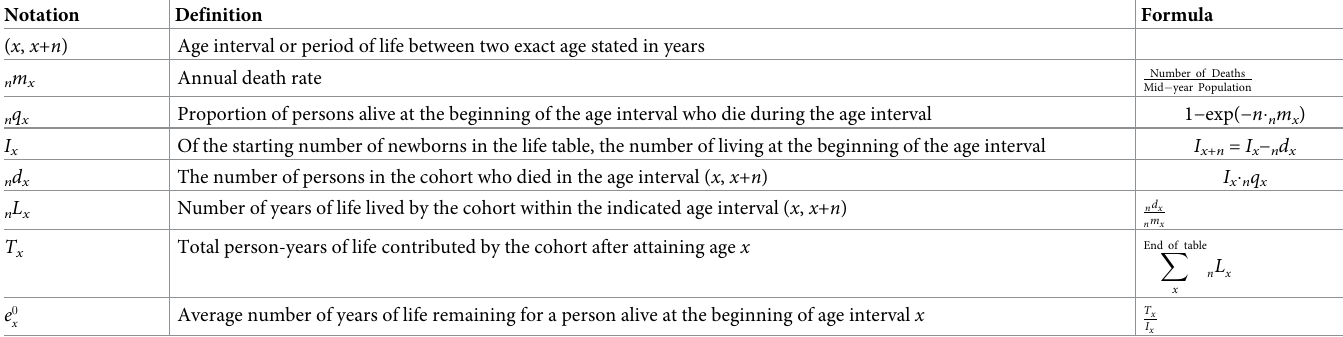
Table 1. Notation, definition, and formula of each column of an abridged life table to calculate life